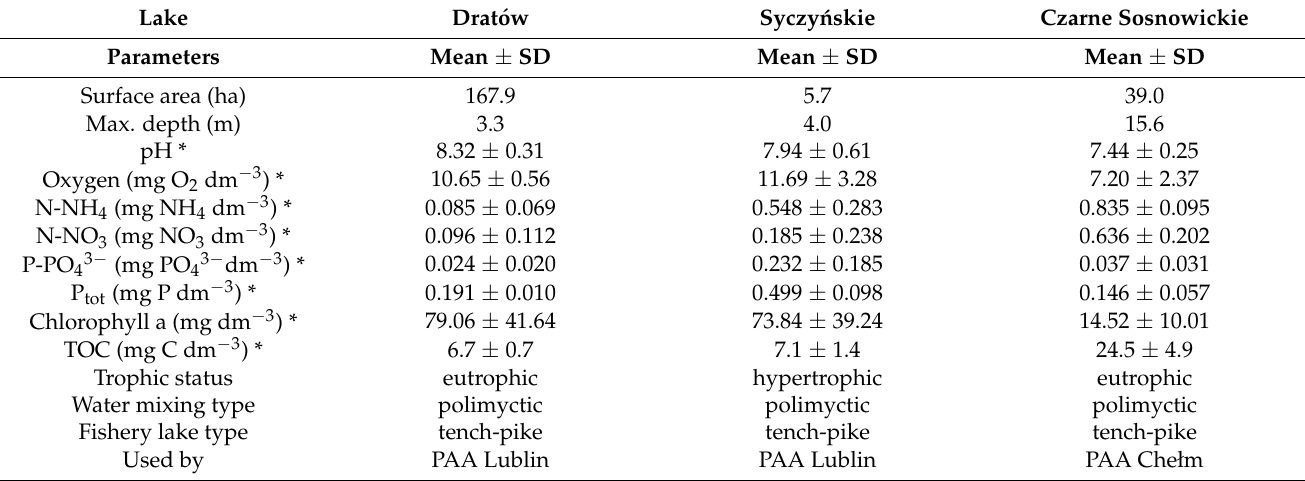
Table 1. Characteristics of the studied lakes.